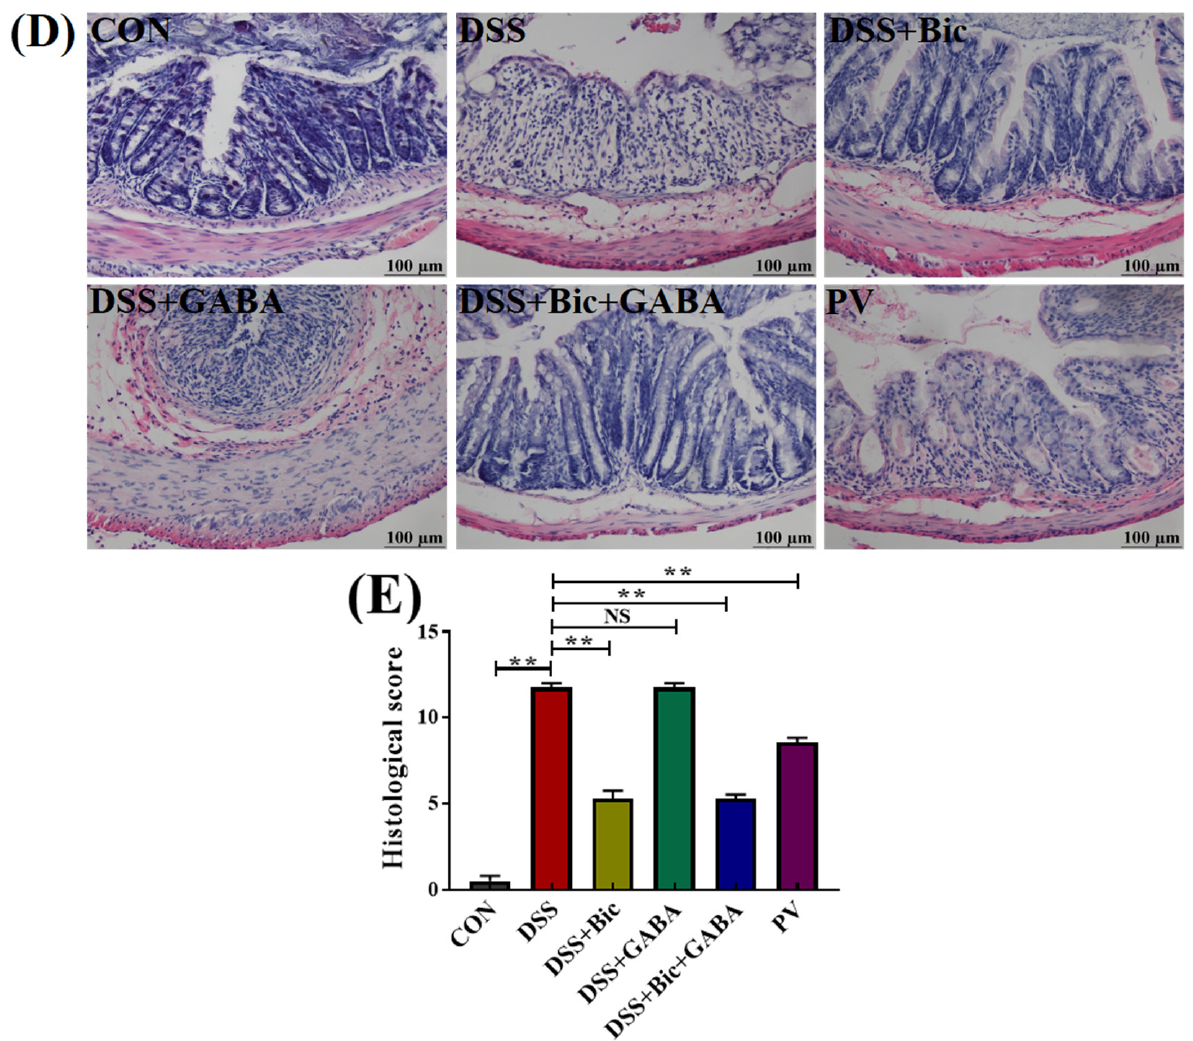
Figure 2. Effect of GABAergic signal and L. casei Zhang on DSS − induced colitis mice. Mice receiving 4% DSS in drinking water were treated with or without Bic and GABA during the six − day experiment. ( A ) Body weight loss. ( B ) Colon length. ( C ) DAI scores. ( D ) Representative H&E staining images of a colon. Scale bar = 100 µ m. ( E ) Histological score. Data are presented as mean ± SEM ( n = 10 per group). * p < 0.05, ** p < 0.01 vs. the control group; # p < 0.05, ## p < 0.01 vs. the DSS group. NS indicates no significant change.